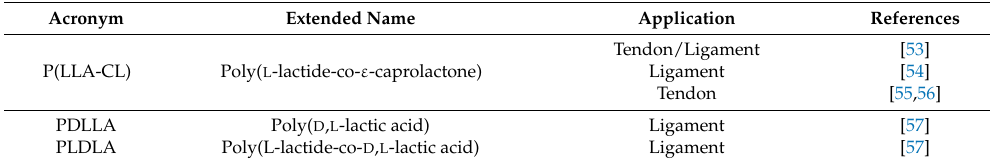
Table 1. Materials used in combination with electrospinning processes, in tendon and ligament tissue engineering.